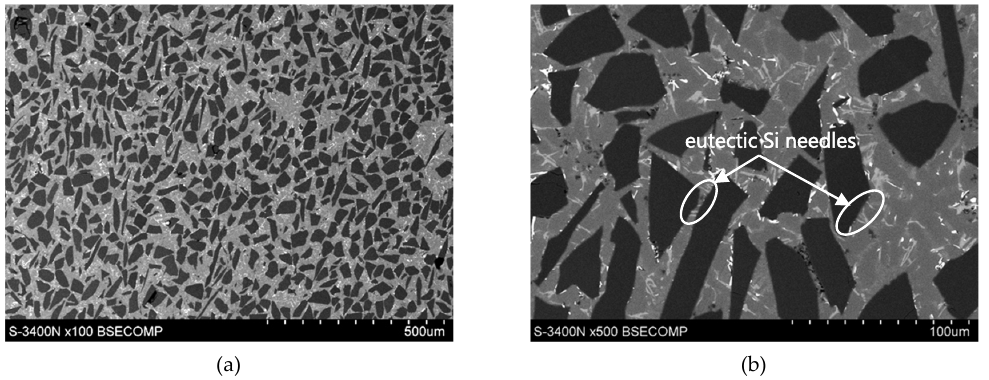
Figure 6. ( a , b ) SEM microstructure of the AlSi12/SiC p composite layer in the outer region with the highest amount reinforcement marked in Figure 5; unetched section.